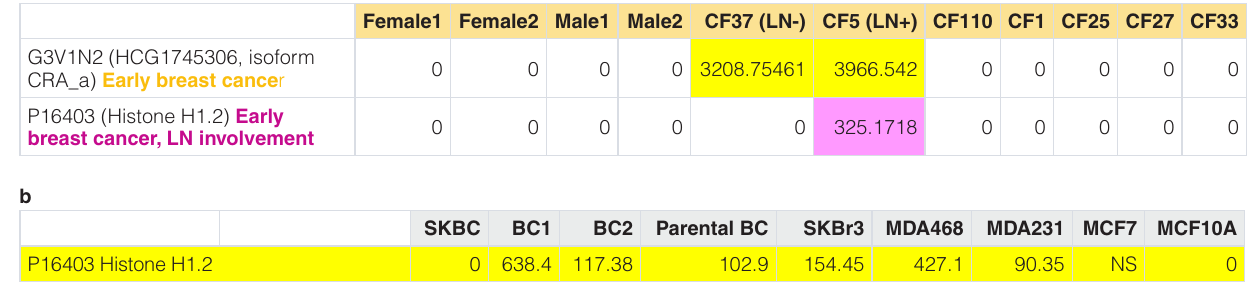
Table 2. a–b, Plasma EV-derived candidate biomarkers for early ER+ breast cancer and LN involvement. Also, represented the Mascot scores for each protein in each sample. a